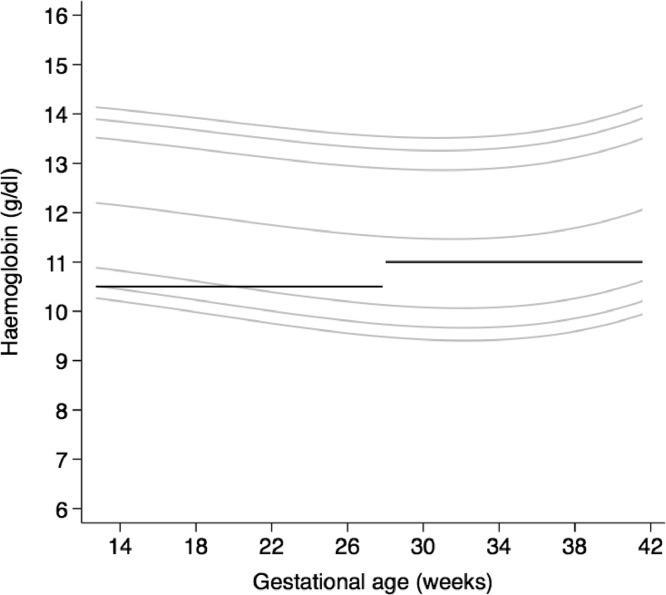
represents smoothed, gestational age-specific, 3rd, 5th, 10th, 50th, 90th, 95th and 97th centiles for maternal haemoglobin superimposed on the current recommended WHO cut-offs for pregnant women in the second and third trimesters (black solid lines).